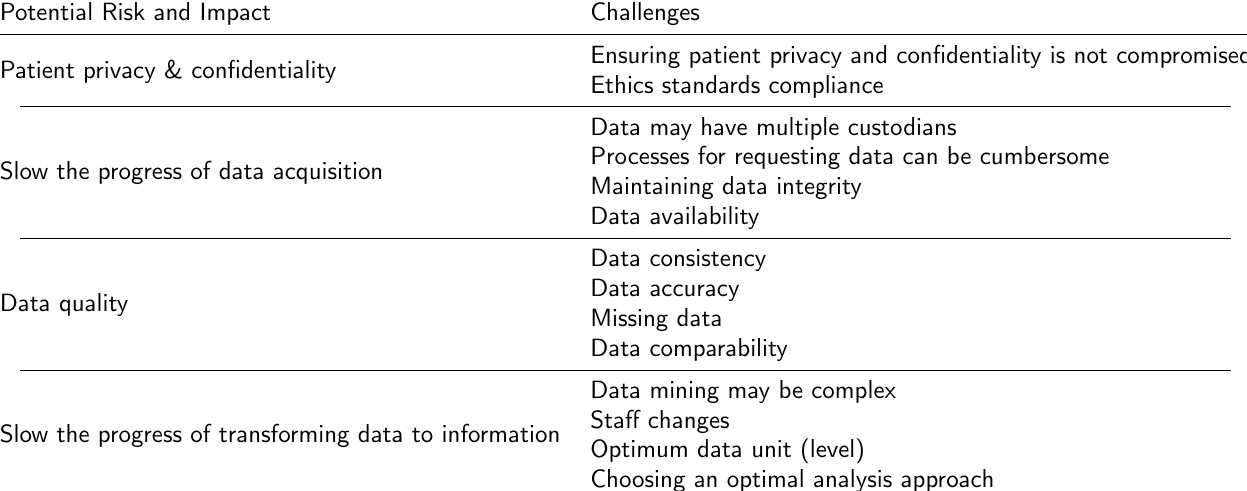
Table 1: List of challenges and their potential risk and impact